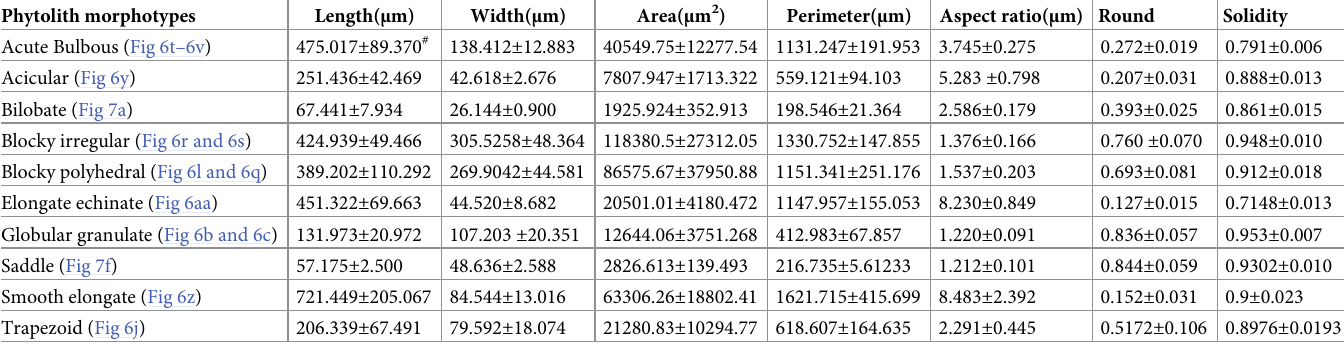
Table 5. Morphometry of phytolith morphotypes of Acrachne racemosa (Heyne ex Roem. & Schult.) Ohwi (Synflorescence). Phytolith